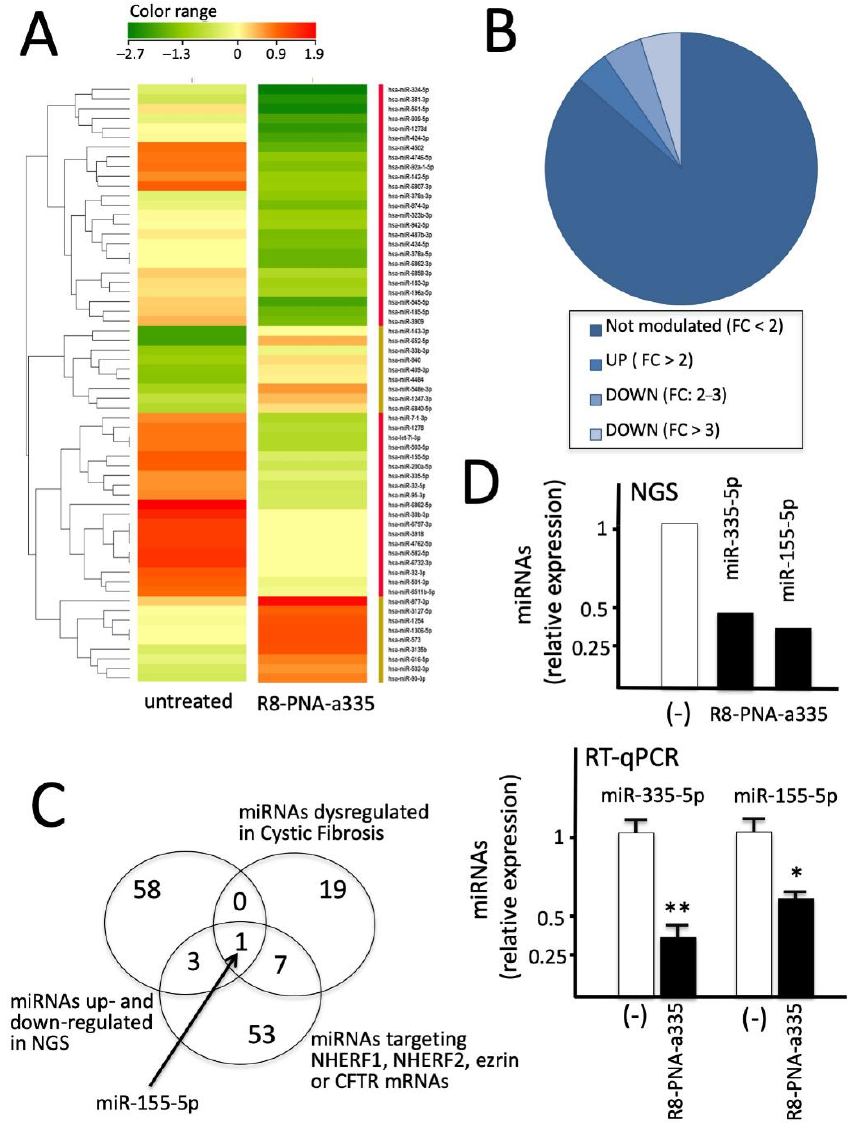
Figure 7. Effects of R8-PNA-a335 on miRNome profile analyzed by NGS sequencing. ( A ) Calu-3 cells were cultured in the absence or in the presence of R8-PNA-a335 for 48 h, RNA was extracted and NGS performed as described in the Materials and Methods section. ( B ) Summary of the number of miRNAs not modulated, or up- (FC > 2) and down- (FC: 2–3; FC > 3) modulated. ( C ) Venn diagram showing miR-155-5p as the only miRNA in common with the three lists (miRNAs up- and down-regulated in NGS, miRNAs dysregulated in CF and miRNA targeting NHERF1, NHERF2, Ezrin or CFTR mRNAs). ( D ) Validation of the R8-PNA-a335 mediated down-regulation of miR-155-5p by RT-qPCR. Data were derived by three independent experiments. Statistical comparisons were made using a nonparametric ANOVA test (* p < 0.05, ** p < 0.01).